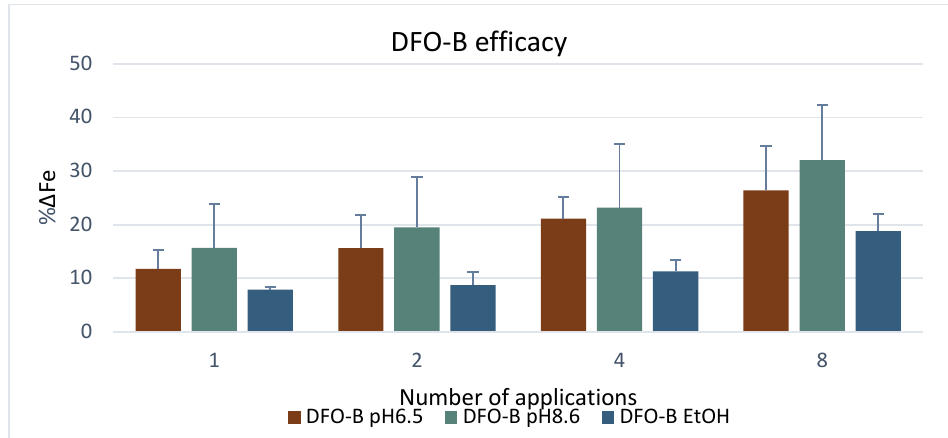
Figure 5. Cleaning efficacy (%ΔFe) calculated from iron weight (%wt) detected via EDS on mock-ups after 8 applications of DFO-B at pH 6.5, at pH 8.6 and dissolved in ethanol. All values are averages of four replicates.